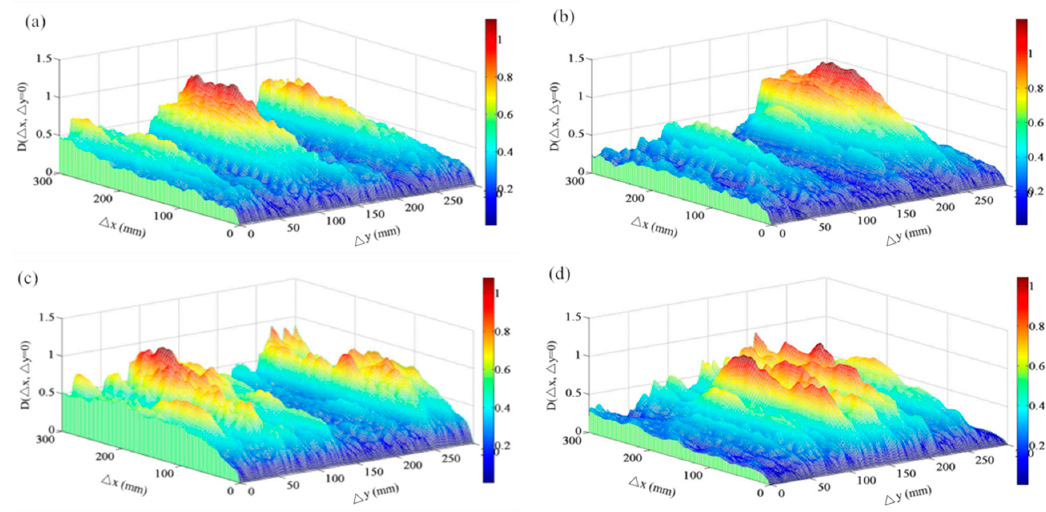
Figure 10. The second-order structure function change along the longitudinal direction in Run 1~2: ( a ) Run 1-0; ( b ) Run 1-1; ( c ) Run 2-0; and ( d ) Run 2-1.